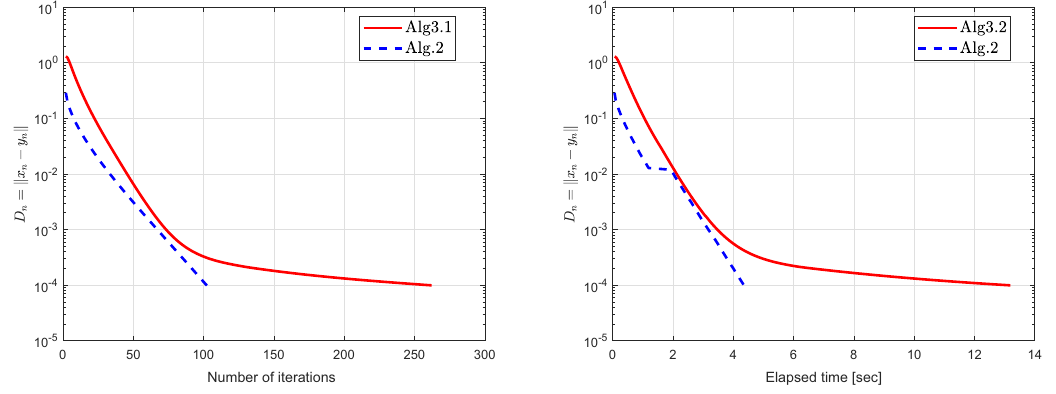
Figure 6: Example 6.2: Algorithm 2 and Algorithm 3.2 in [ 31 ] . Comparison by using ( ) = x 1, 1, 1, 1, 1 T 1 .